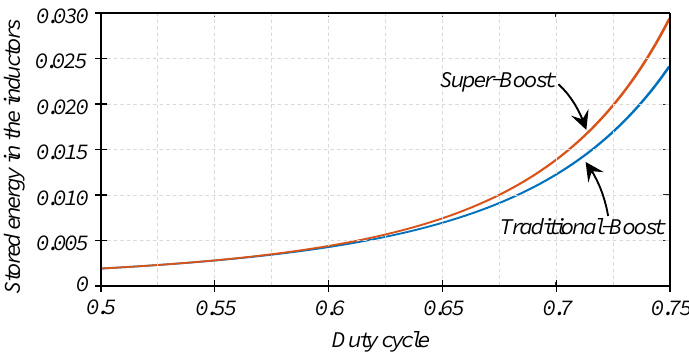
Figure 5. Comparison of stored energy in inductors between the traditional boost and the super-boost converter for a case with the same input current ripple.